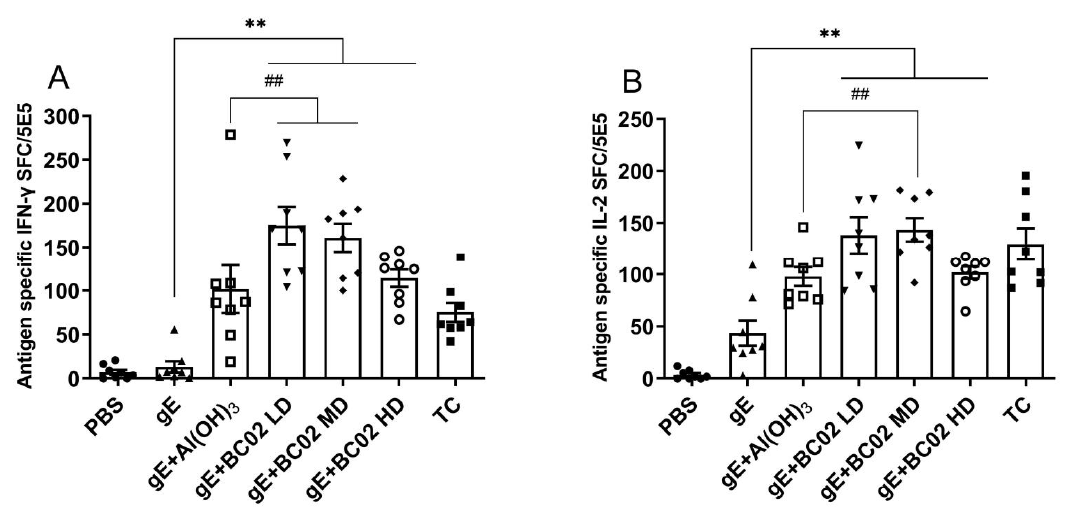
Figure 3. BC02-adjuvanted experimental vaccine induces gE specific cellular immune response. ( A , B ): The average number of gE-specific IFN- γ and IL-2 spots forming cells (SFC) in differently immunized mice at 56 days post immunization determined by ELISPOT. Eight mice per immunization group. ** and ## indicates that there is a significant statistical difference between gE + BC02 LD/MD/HD compared with gE, or gE + Al(OH) 3 , respectively, p < 0.05. LD: Low dose, MD: Medium dose, HD: High dose.